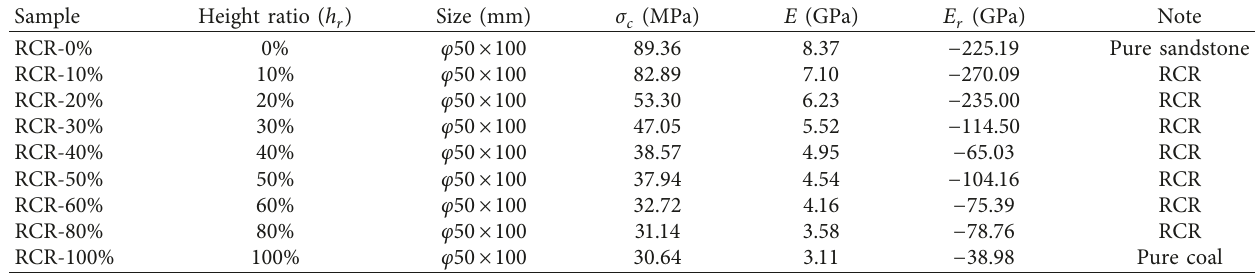
Table 2: Uniaxial compressive strength, elastic modulus, and postpeak modulus of RCR samples. Sample